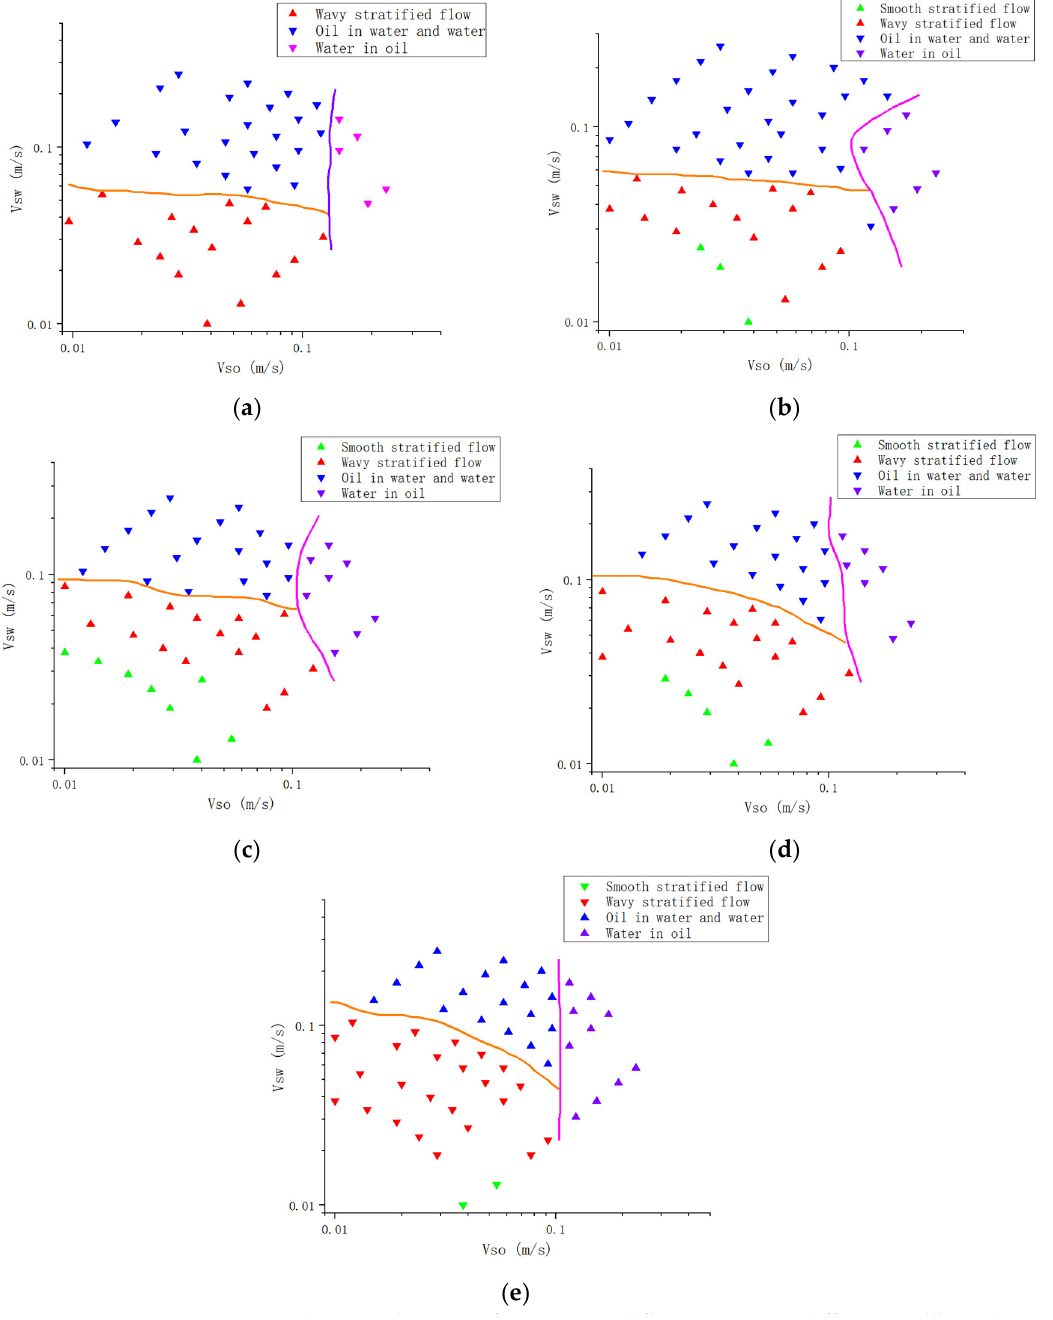
Figure 4. Schematic diagram of experimental flow patterns at different wellbore deviation angles. PD represents wellbore deviation angle; ( a ) OW-PD85; ( b ) OW-PD92; ( c ) OW-PD90; ( d ) OW-PD92; ( e ) OW-PD95.